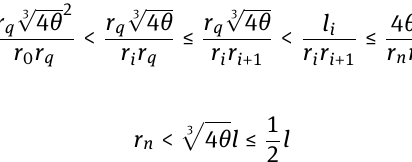
√ 4 θ -chain in ( X , d